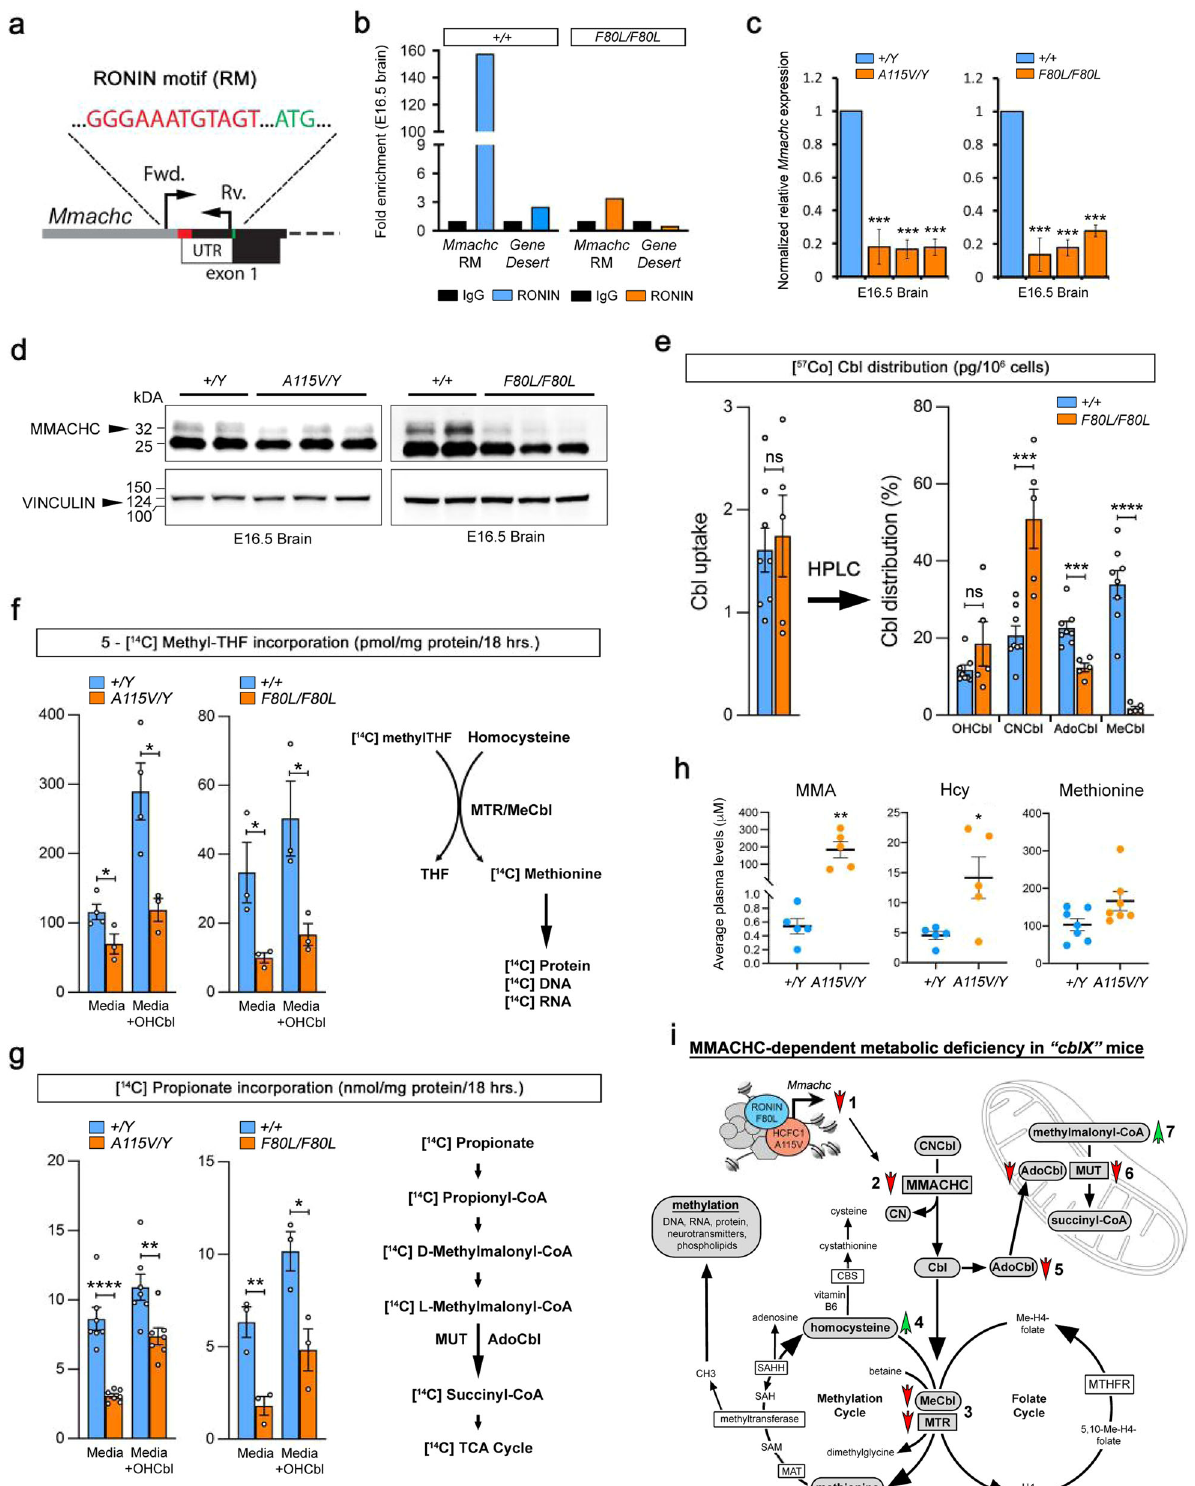
dimensional quanti fi cation of surface area, length, and width of the craniofacial bones as previously described 44 . We determined that the average surface area of the nasal, frontal, and parietal bones are smaller in Hcfc1 A115V/Y mutant mice while no differ- ence shown in interparietal bones. Nasal bone length, nasal bone width, and frontal bone length are shorter in the mutant mice. Frontal bone width, parietal bone length, interparietal